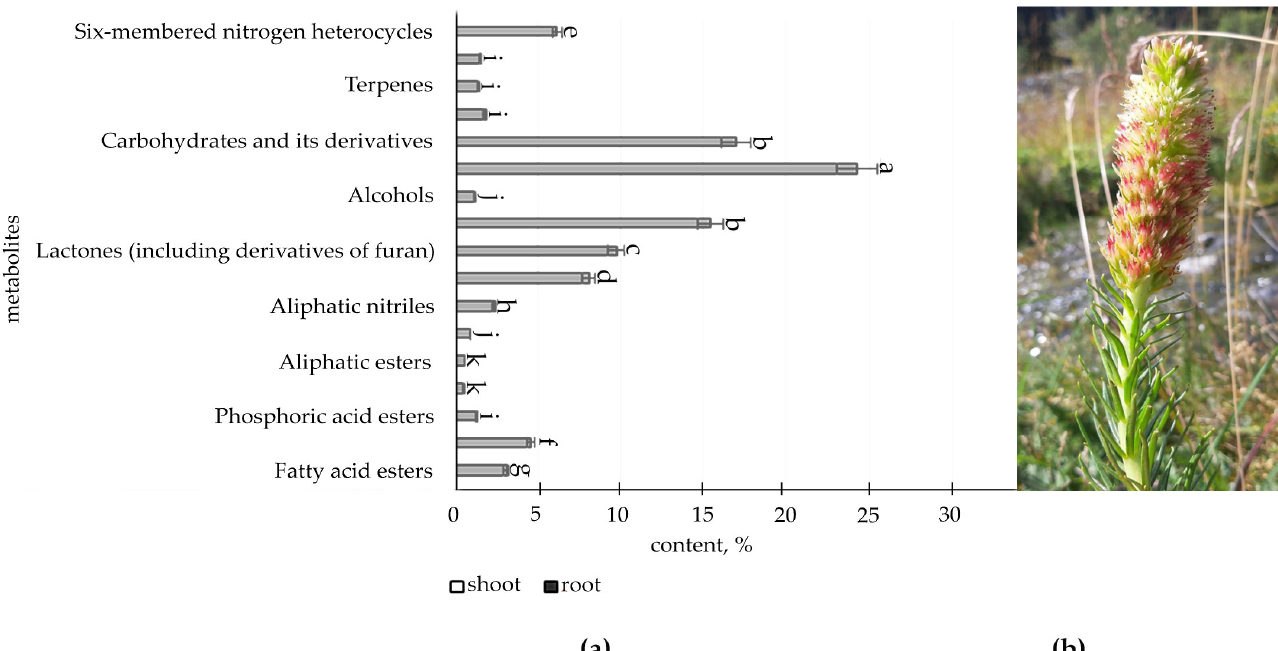
Figure 2. ( a ) Content of secondary metabolites classes in root and shoot of flowering plants R. se- menovii , %. Values presented are means (±SD). Different letters above the bars represent significant differences at p ≤ 0.05, n = 3 plants in each of 3 replicates for all treatments; ( b ) flowering plants R. semenovii .